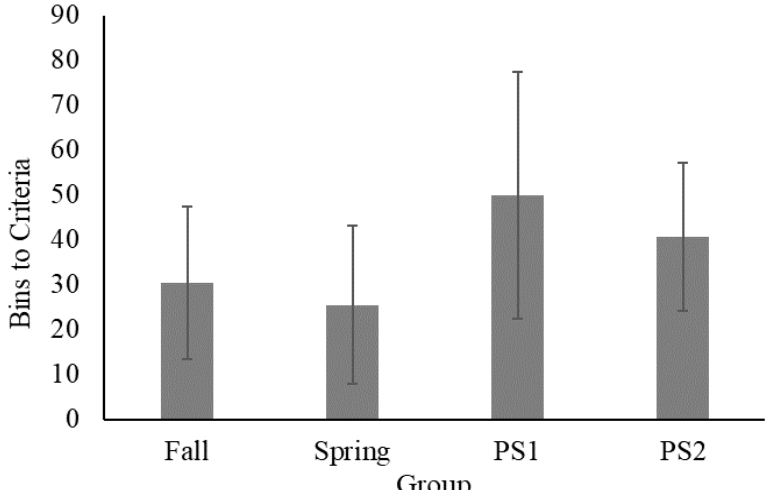
Figure 2. Number of bins needed to reach criteria during the DIS stage across all groups. Error bars are standard error of the mean (SEM).